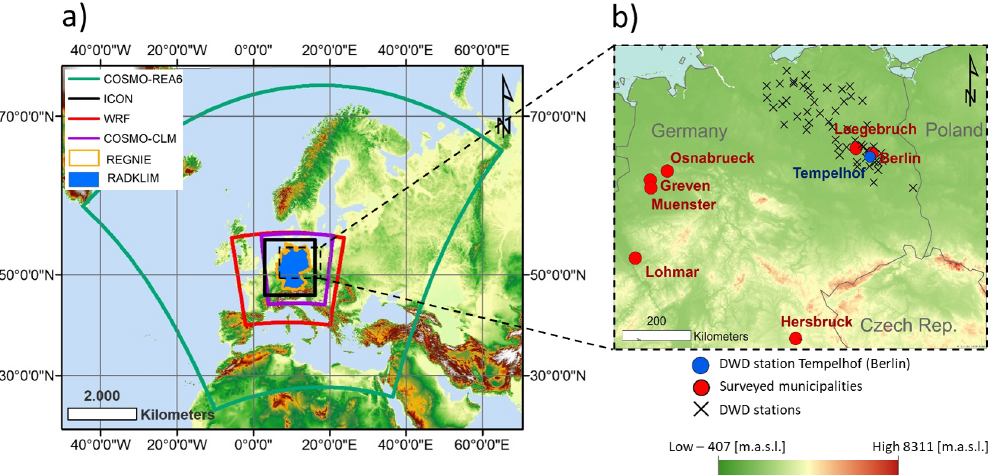
Figure 1. (a) Spatial extent of the used data sets REGNIE, RADKLIM, COSMO-REA6, WRF-1.5km, ICON-625m and COSMO-CLM- 2.8. (b) Close-up view of Berlin and surroundings, and the DWD stations used for validation (crosses), the location of surveyed events from Table 1 (red dots) and the Berlin–Tempelhof station analysed in Fig. 11 (blue dot), basemap: Global Land One-kilometer Base Eleva- tion (GLOBE) (Hastings et al.,